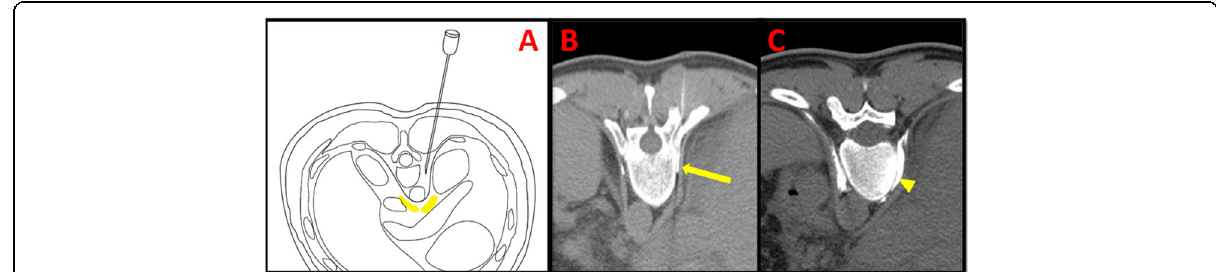
Fig. 8 Retrocrural neurolysis. Schematic ( a ) and axial CT section of the pre-procedure ( b ) with needle tip in the left retrocrural space and post- procedural free flow of contrast ( c ) in the retrocrural space